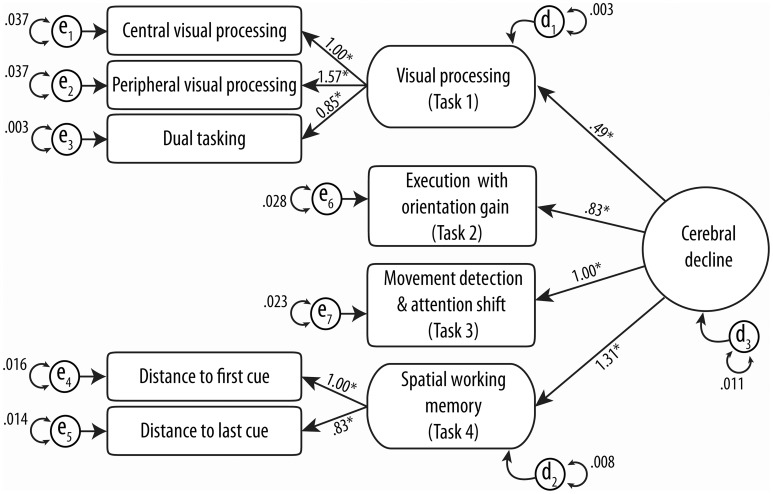
Confirmatory structural equation modeling of MedDrive's theoretical construct. Circles and rounded-cornered squares represent latent variables. Numbers above straight lines correspond to weights of score for MedDrive outcomes to best model “cerebral decline.” en models residual errors for observed variables and dn models the same errors for latent variables. *Identifies variables that contribute significantly (LRtest p-value < 0.05) to the model.